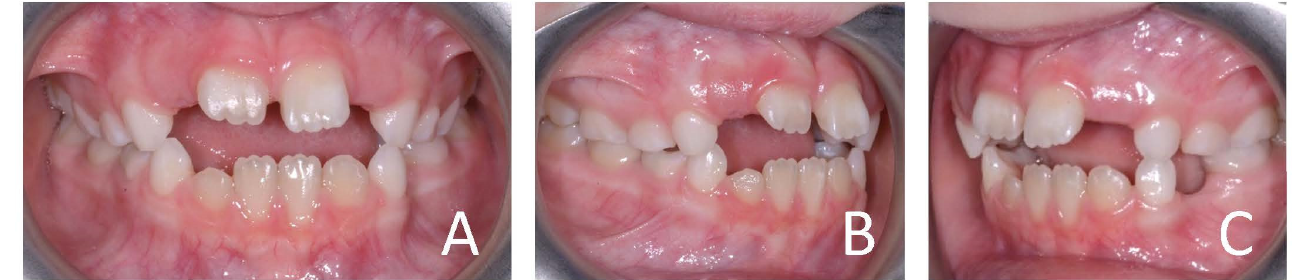
Figure 30. Intraoral photographs of the subject before the treatment (8-year-old). ( A ) Frontal view; ( B , C ) lateral view.